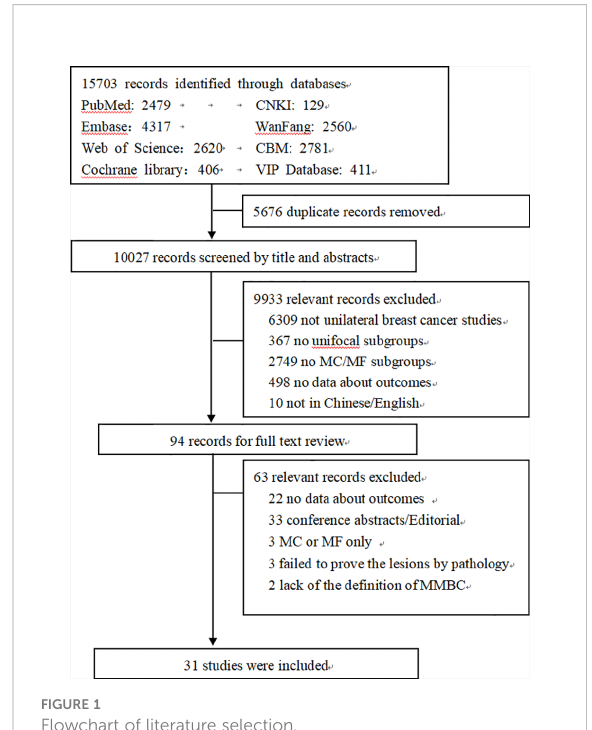
FIGURE 1 Flowchart of literature